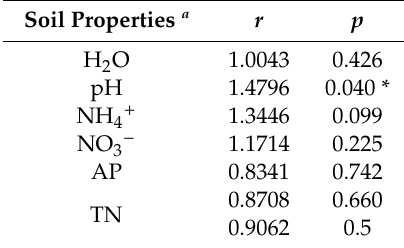
Figure 5. Heat map of the bacterial community showing the profiles-clustered results from plot abundances of the 16S rRNA gene at genus-level in bulk soils, rhizosphere, root, and spikelet of wheat.FO: no fertilizer, control; LF: low fertilizer; FH: high fertilizer; OM: manure; and BC: biochar. Table 1. The relationship between the soil parameters and the bacterial community structure in the bulk